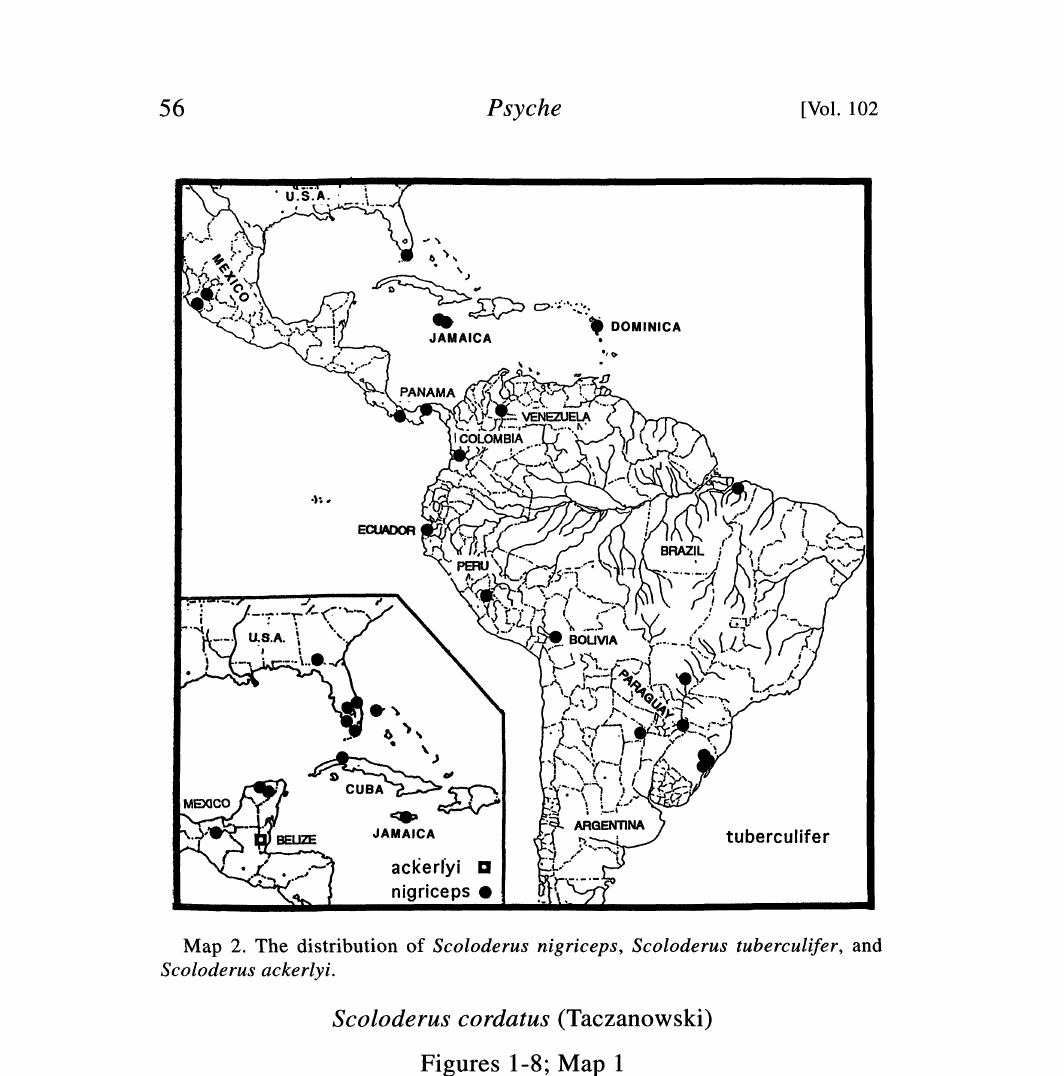
Map 2. The distribution of Scoloderus nigriceps, Scoloderus tuberculifer, and Scoloderus